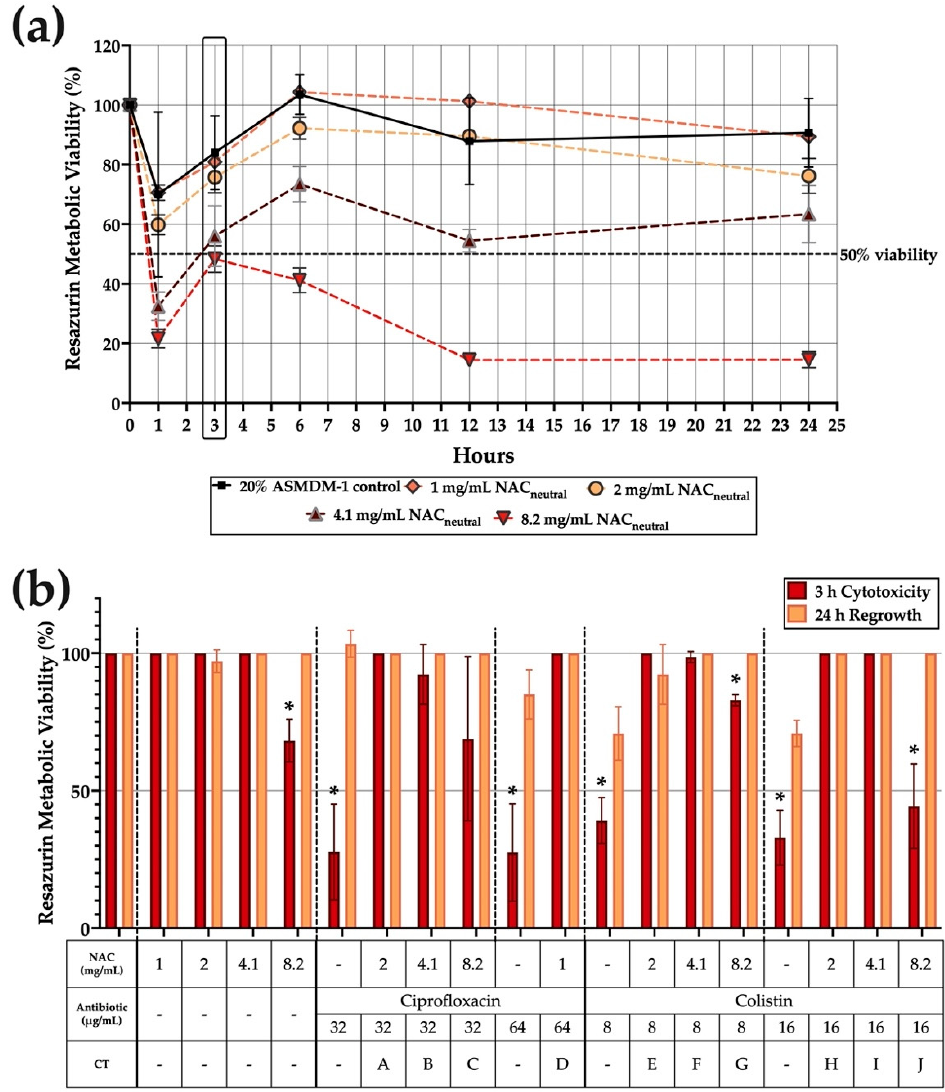
Figure 2. BEAS-2B cells experience minimal cytotoxicity following three-hour combination treat- ment challenge. BEAS-2B cells were grown to confluence and the cytotoxicity of NAC neutral CT made in 20% ASMDM-1 (as detailed in Table 1) was tested. ( a ) Cytotoxicity of NAC neutral was measured using resazurin metabolic viability staining over 24 h to determine viability. ( b ) Regrowth following three hours of treatment with CT and individual components were assessed after 24 h. (*) indicates the results are statistically significant ( p ≤ 0.05) based on unpaired Student’s t -tests (with Welch’s correction).